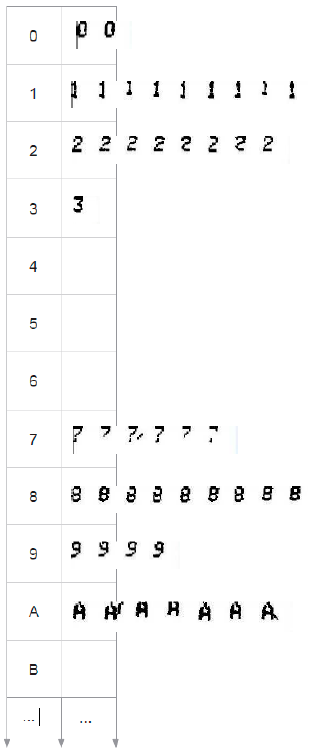
Figure 8. Representation of the Morphological Family Base (MFB) of